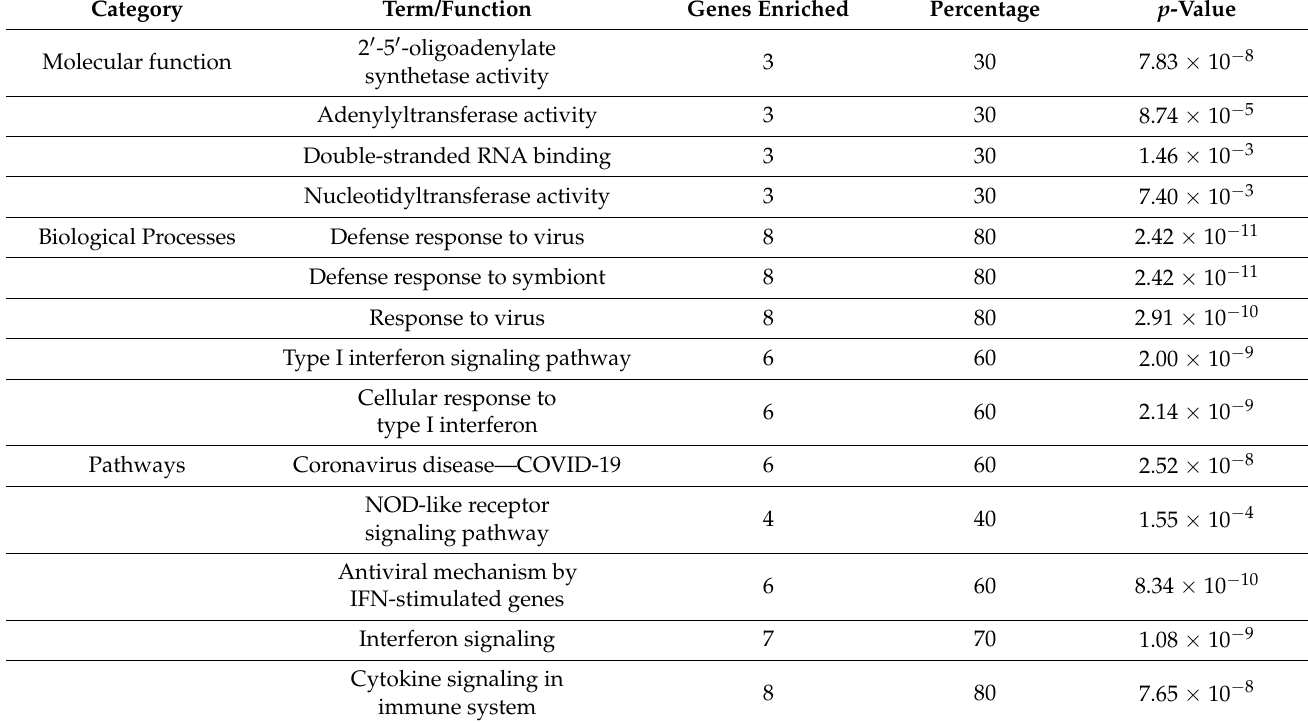
Table 4. Gene ontology enrichment classification of selected hub genes